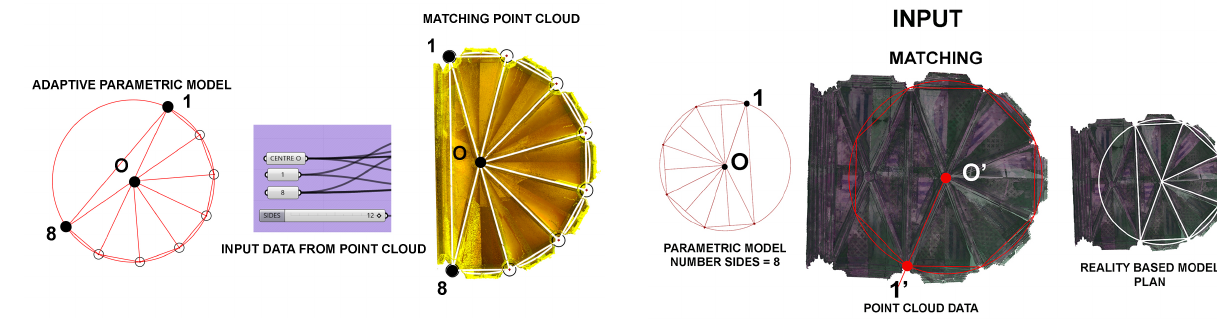
Figure 14 . Church of S. Lorenzo apses vault: matching the adaptive model on point cloud